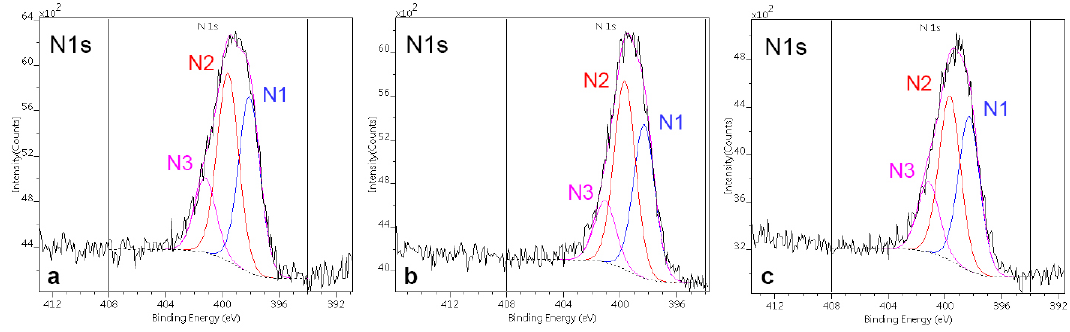
Figure 5: C1s, N1s and O1s lines of the SLGO samples treated at different bias (untreated black, 0 V blue, 50 V red, 100 V green, 200 V magenta) (colour online) .